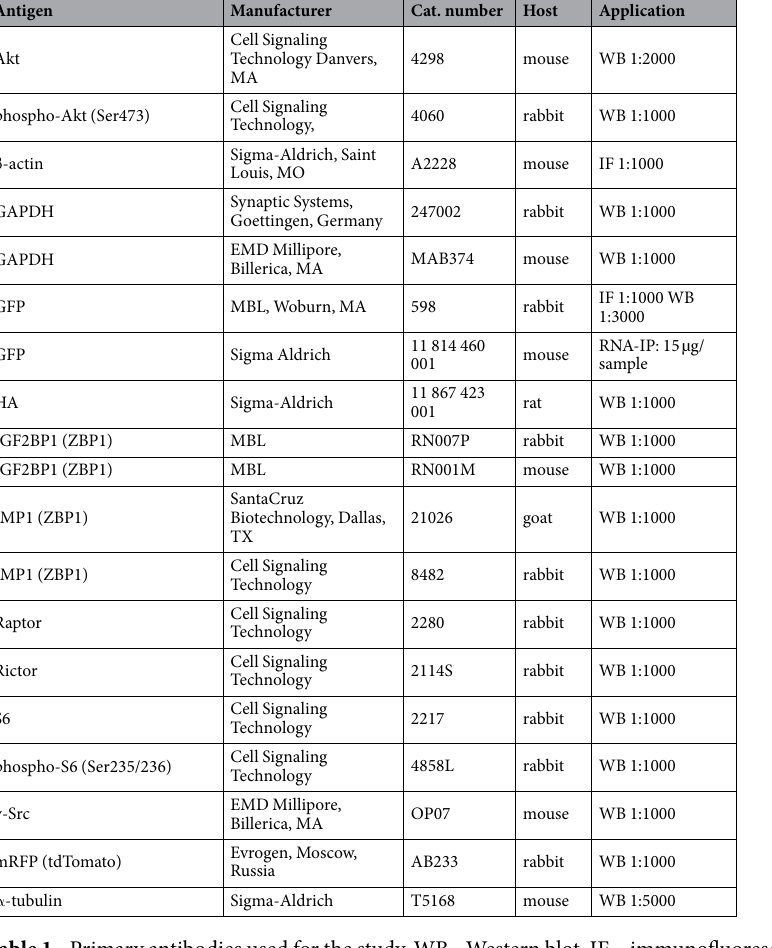
Table 1. Primary antibodies used for the study. WB - Western blot, IF –